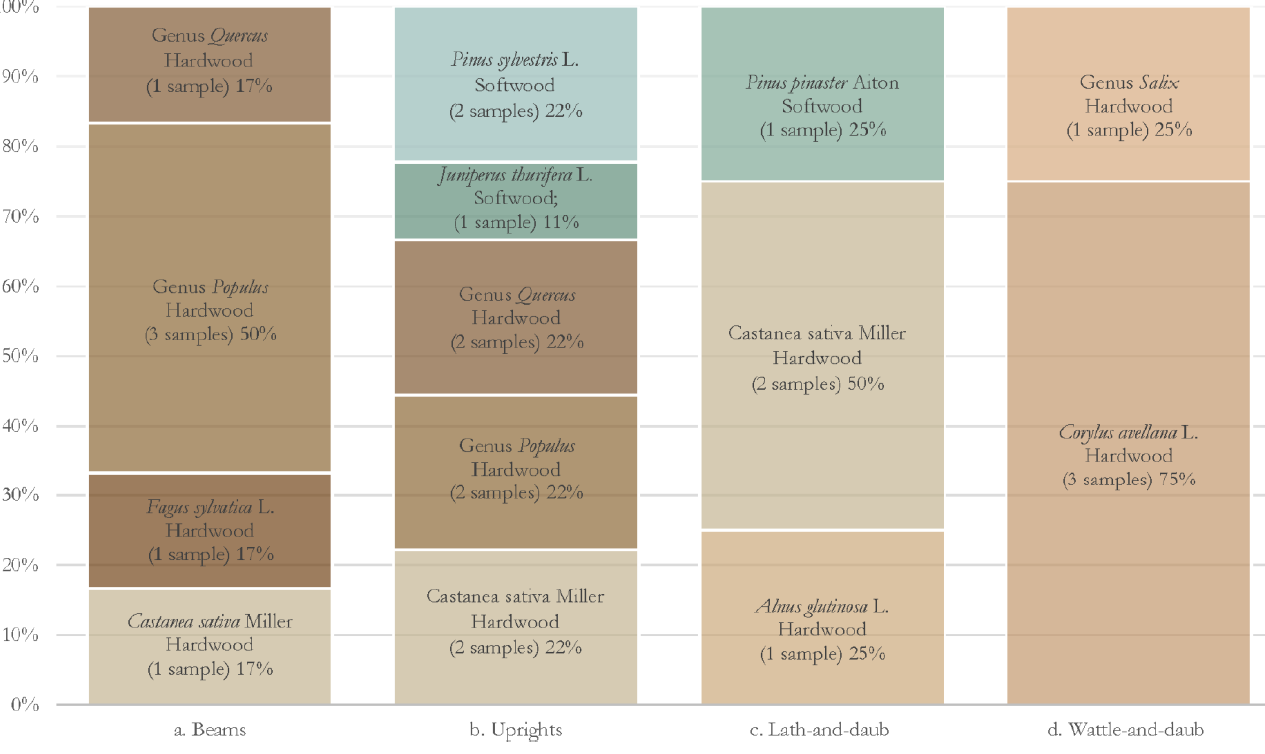
Figure 24. Distribution of the different species identified based on their presence in structural elements such as beams and uprights or in enclosure elements such as laths or flexible rods.